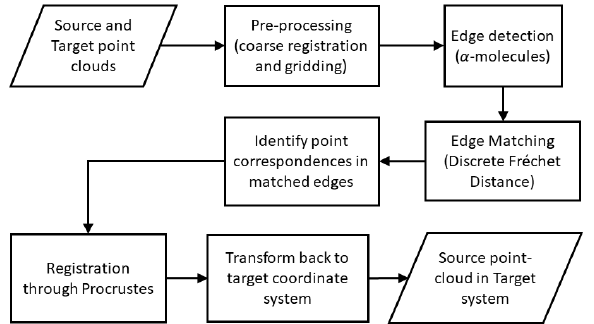
Figure 1. Flowchart of proposed registration algorithm.